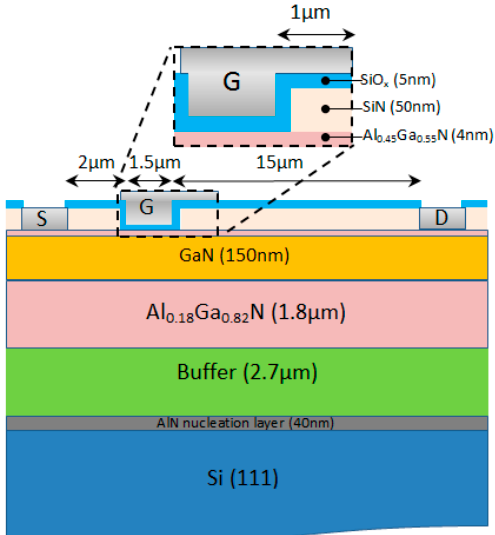
Figure 1. Metal-oxide-semiconductor high-electron-mobility transistor (MOS-HEMT) cross section.